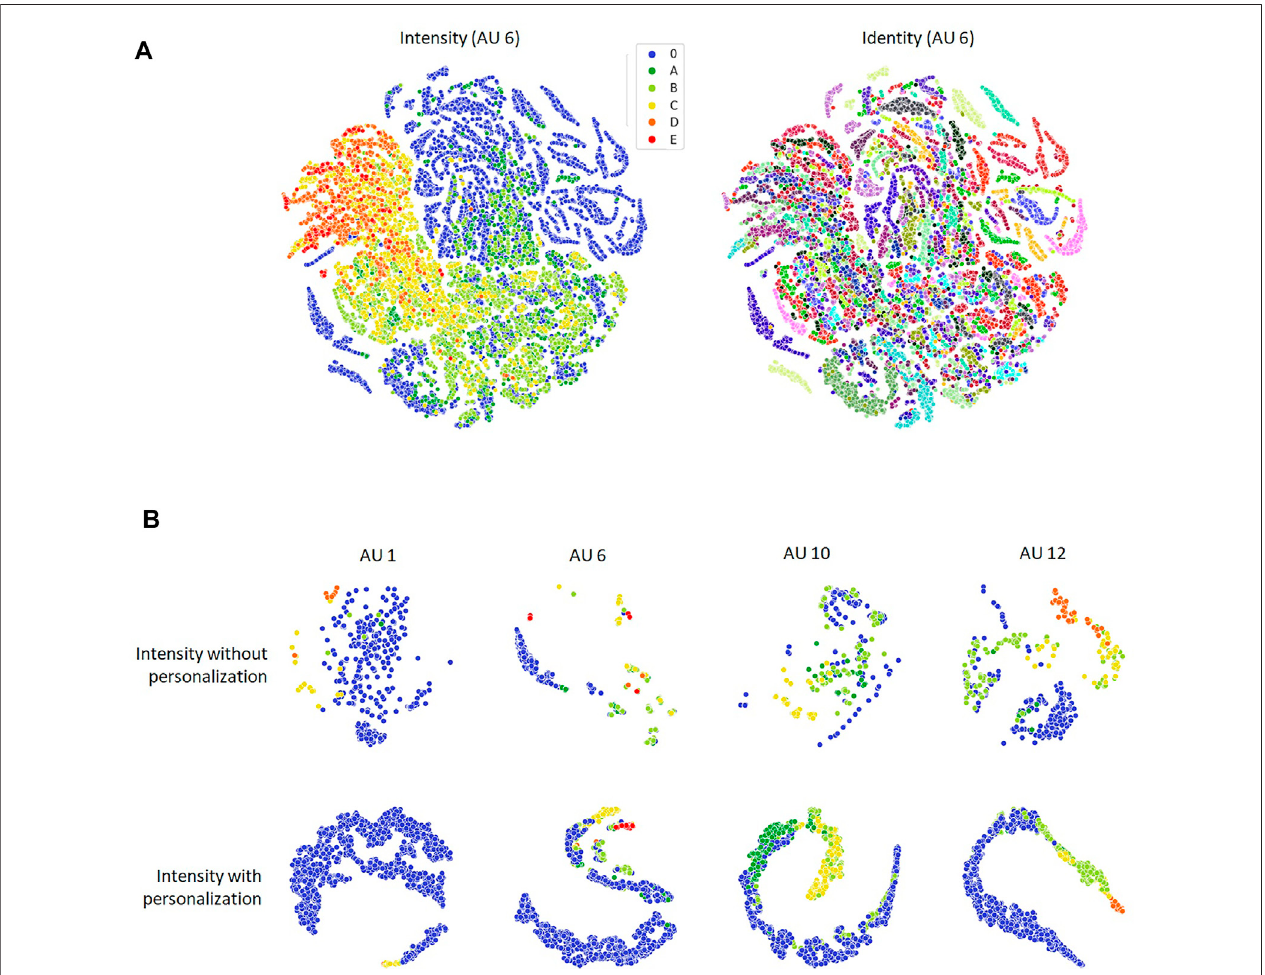
FIGURE8| t-SNEvisualization. (A) SeparationofourmodeltrainedwithoutpersonalizationforAU6intermsofAUintensityandidentity. (B) Intensityseparationfor AU 1, 6, 10 and 12 between models without and with personalization for the same subject.